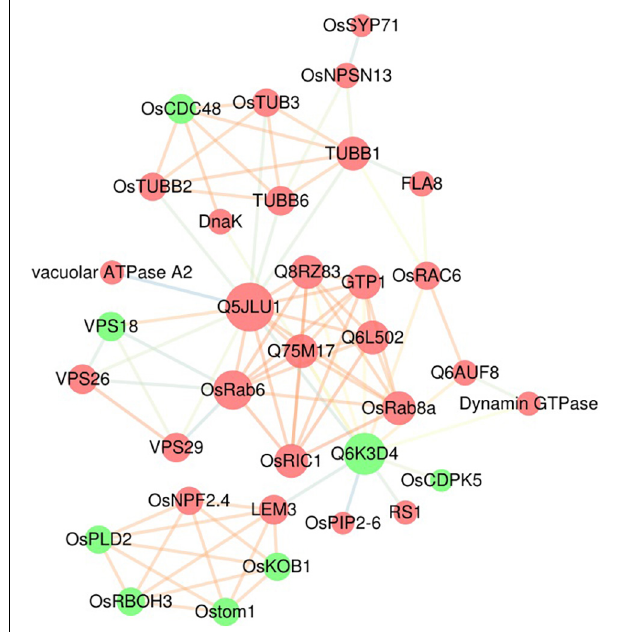
FIGURE 5 | Protein–protein interaction network of DEPs. A protein–protein interaction network of DEPs associated with vesicle trafficking (including the transport terms from the GO analysis and the phagosome and endocytosis terms from the KEGG analysis) was built using the STRING database. Identified interactions with confidence scores ≥ 0.4 were visualized using Cytoscape software. The red nodes are upregulated DEPs, and the green nodes are downregulated DEPs; the size of the nodes represents the number of related interactions in the network; and the colors of the edges indicate the strength of the interaction: orange represents a strong interaction, and blue represents a weak interaction. change Exo70 were upregulated at 8 h, 24 h and 72 h after M. oryzae infection, while Sec1 was downregulated at 8 h ( Figure 6